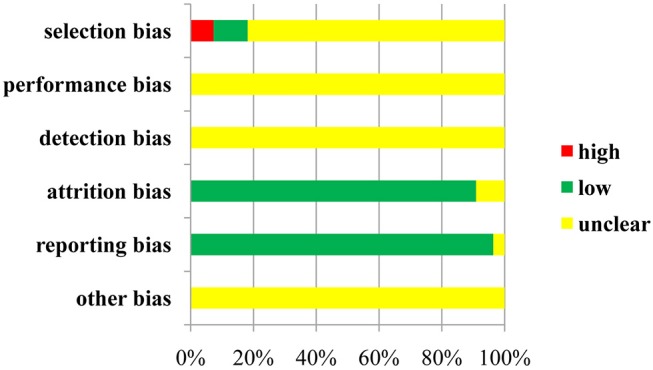
Risk-of-bias graph.